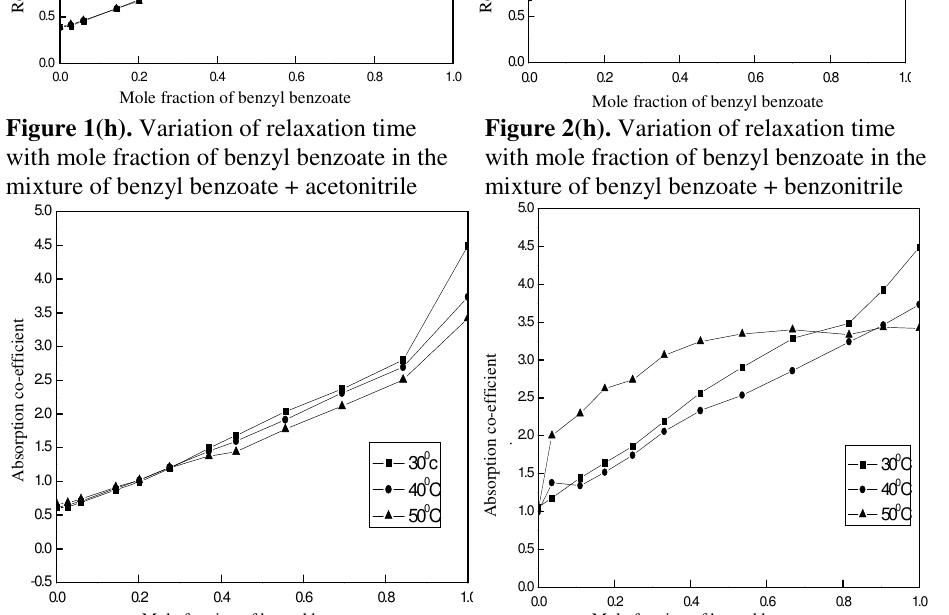
Figure 1(i). Variation of absorption co- efficient with mole fraction of benzyl benzoate in the mixture of benzyl benzoate + acetonitrile